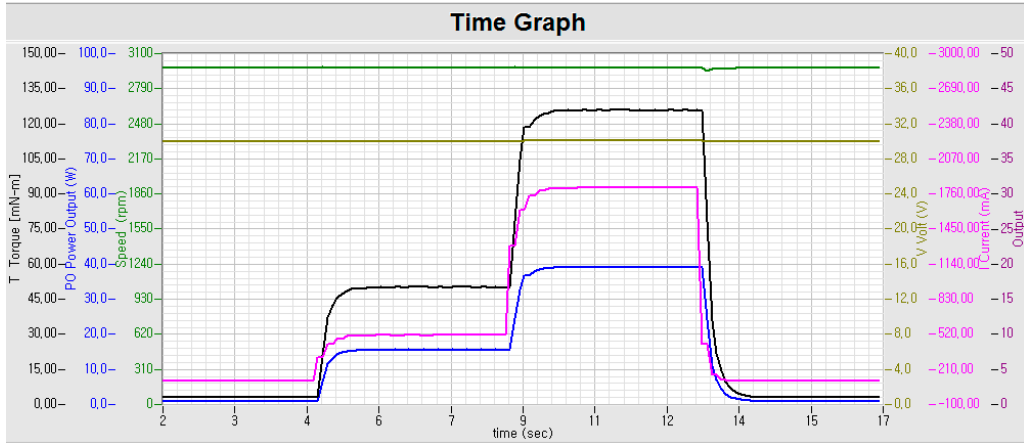
Figure 14. Output waveform of the motor performance tester. (Operating condition: ω r = 620 rad/s, permanent magnet temperature = 25 °C).